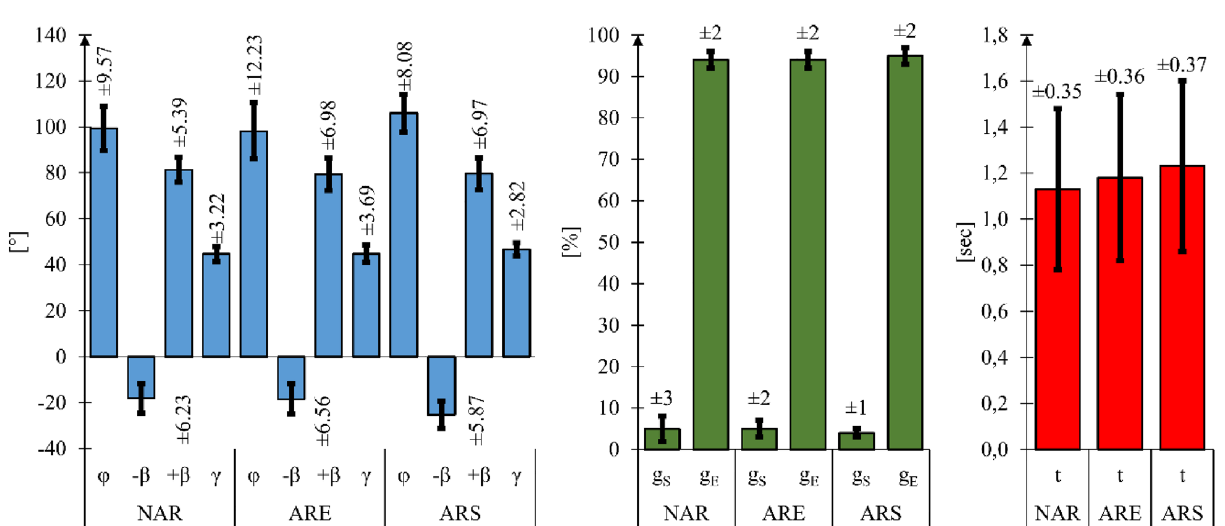
Figure 11. Results of the motion capture measurement analysis of the push phase for the wheelchair without an anti-rollback system (NAR), with a flexible anti-rollback system (ARE) and with a stiff anti-rollback system (ARS). In these graphs: φ—the total push-rim rotation angle, -β—the angular position of the hand on the push- rim at the beginning of the push phase, + β—the angular position of the hand on the push-rim at the end of the push phase, γ—the trend line inclination of the function of the total push-rim rotation angle, t—the duration of the push phase, g S —the percentage share of the total push phase duration with the hand gripping the push-rim, g E —the percentage share of the total push phase duration with the push-rim released. All mean values were determined at a 95% confidence interval ( p =